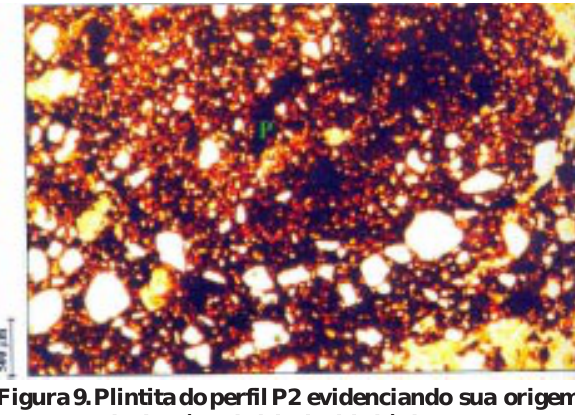
Figura 9. Plintita do perfil P2 evidenciando sua origem associada à atividade biológica. Nota-se o alinhamento dos grãos de esqueleto separando os volumes com quartzo mais fino daqueles de maiores dimensões. O domínio com esqueleto fino corresponde a um pedotúbulo (P), o qual se encontra ferruginizado. Luz normal -